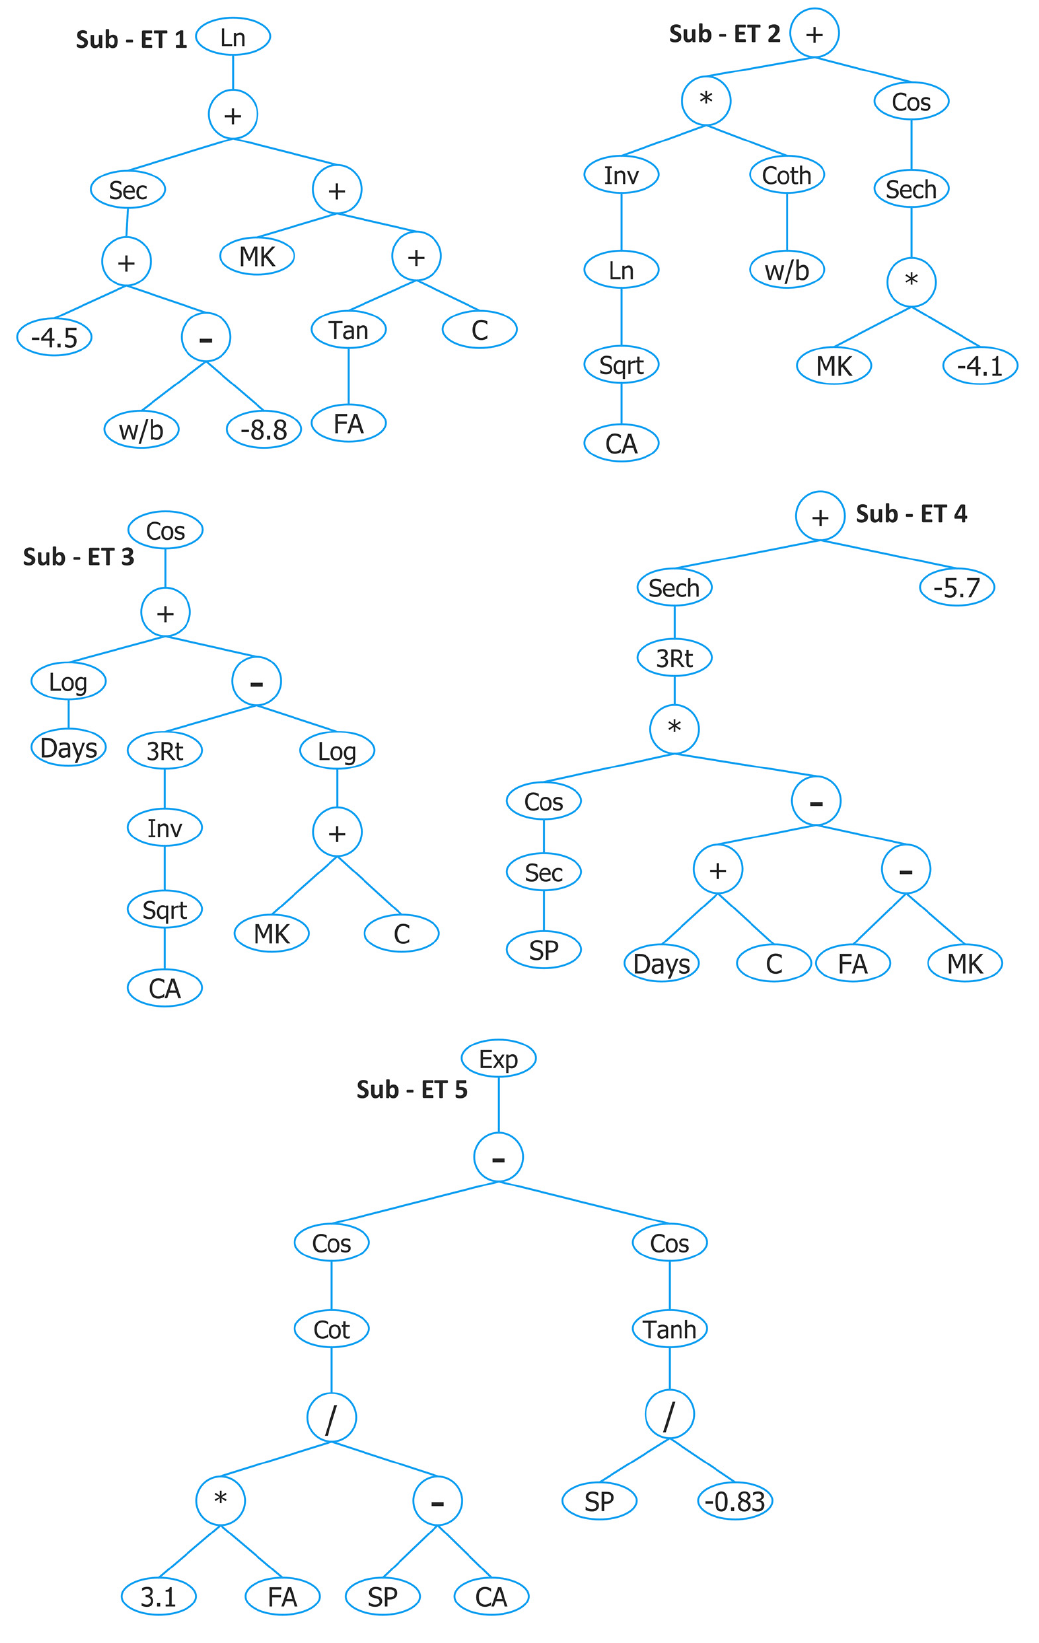
Figure 11. Expression tree of GEP II developed for predicting f st of concrete with